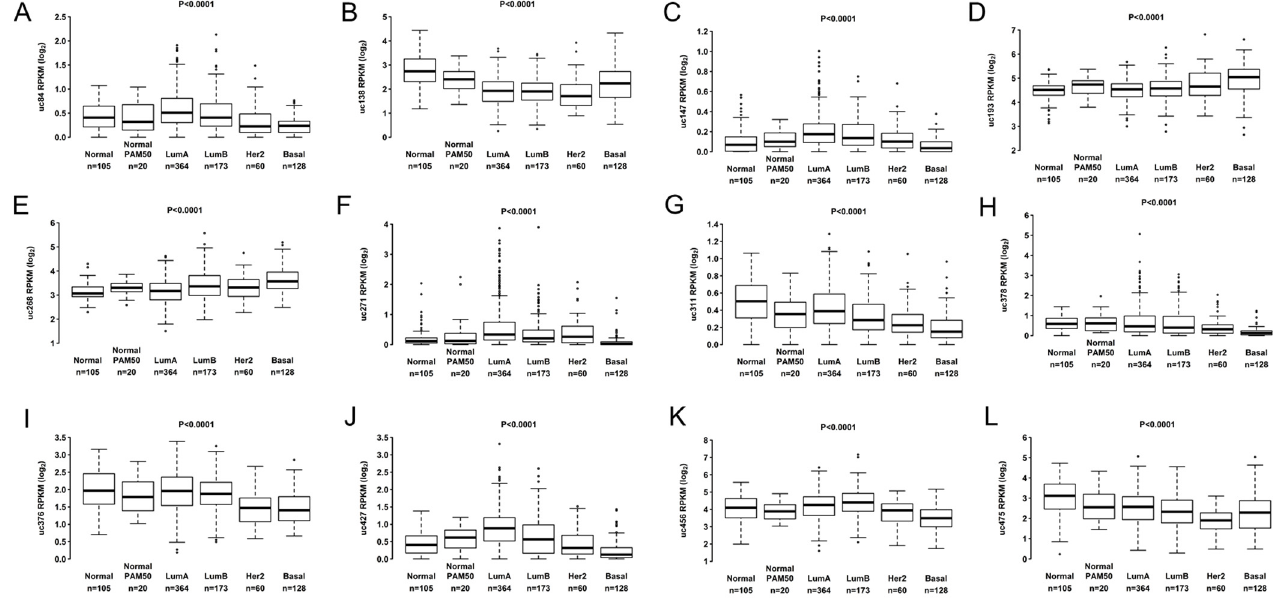
Figure 3. Expression levels of 12 T-UCRs in all breast cancer subtypes from TCGA patients: Normal, Normal PAM50, Luminal A (LumA), Luminal B (LumB), HER2 overexpression (HER2+), and Basal. ( A ) Differential expression level of uc.84, ( B ) uc.138, ( C ) uc.147, ( D ) uc.193, ( E ) uc.268, ( F ) uc.271, ( G ) uc.311, ( H ) uc.378, ( I ) uc.376, ( J ) uc.427, ( K ) uc.456 and ( L ) uc.475 according to PAM50 BC subtypes.